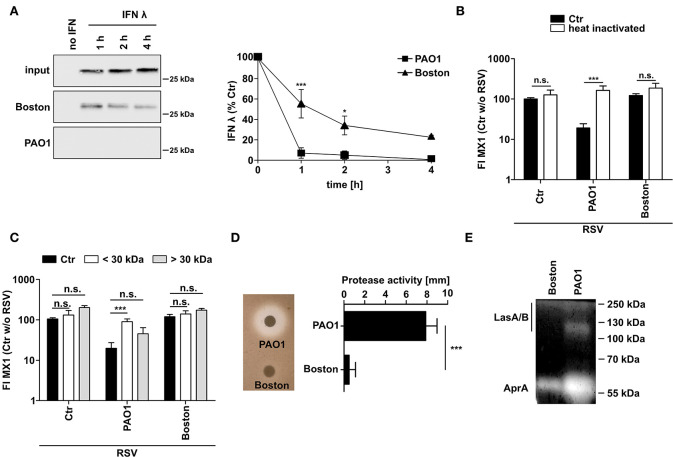
P. aeruginosa secretes a protease degrading directly IFNλ. (A) Recombinant IFNλ was incubated in conditioned medium of P. aeruginosa (PAO1 and Boston) or control medium at 37°C for 1, 2, or 4 h. Subsequently, levels of IFNλ were analyzed by western blot. (B) Conditioned media was heated for 10 min at 95°C. Subsequently BEAS2B cells were pretreated with heat treated or non-treated conditioned medium of P. aeruginosa (PAO1 and Boston) or with control medium and subsequently infected with RSV. Induction of MX1 mRNA was analyzed by qRT-PCR after 14 h post-infection. (C) Conditioned media was filtered using a cutoff of 30 kDa. Subsequently BEAS2B cells were pretreated with the fraction larger than 30 kDa, smaller than 30 kDa, non-filtered conditioned medium of P. aeruginosa (PAO1 and Boston) or control medium and subsequently infected with RSV. Induction of MX1 mRNA was analyzed by qRT-PCR after 14 h post-infection. (D) Protease activity in conditioned medium of P. aeruginosa (PAO1 and Boston) was assessed using skim-milk agar. (E) Elastase activity in conditioned medium of P. aeruginosa (PAO1 and Boston) was assessed by zymography. All experiments n = 3–4, ANOVA and Bonferroni post-test was used for statistical analysis. Significant differences were considered at *p < 0.05, **p < 0.01, and ***p < 0.001 as compared to the control condition. n.s., not significant.